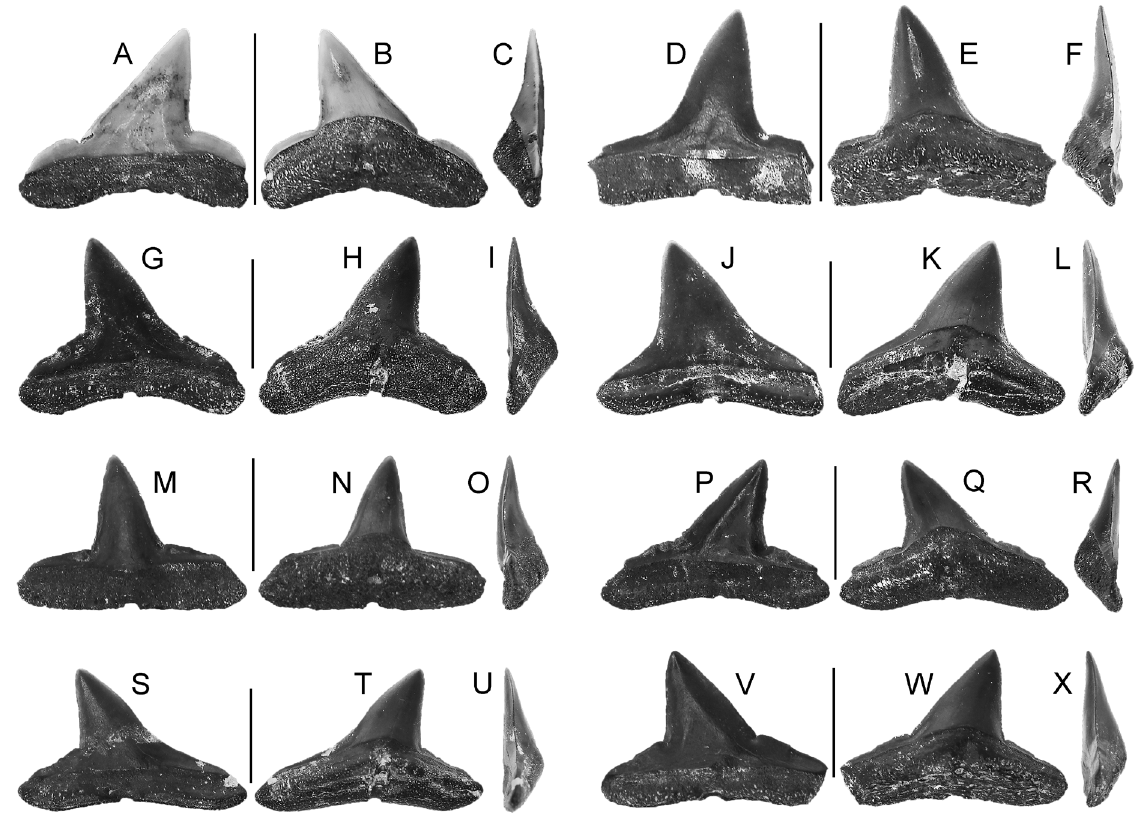
Fig. 27. Negaprion gilmorei (White, 1956), teeth. A–C . MSC 37682.2, upper lateral tooth, basal